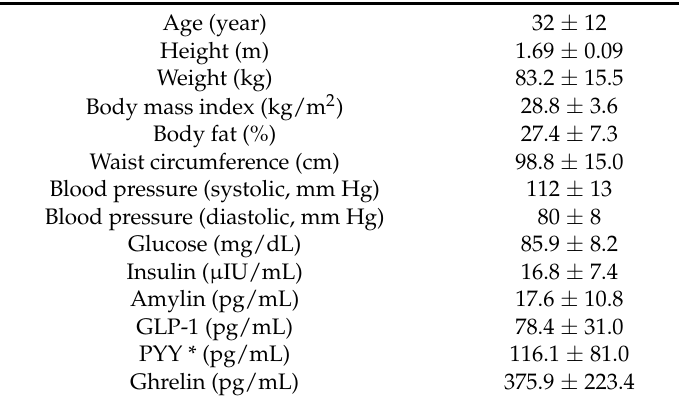
Table 1. Characteristics of